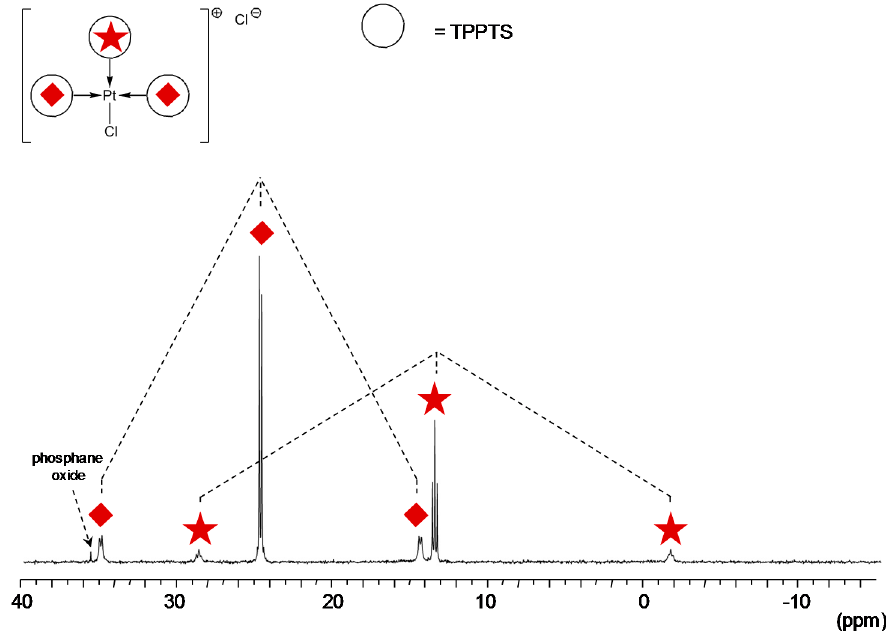
Figure 1. 31 P{ 1 H} NMR spectrum of [Pt(TPPTS) 3 Cl]Cl, [Pt] = 10 mM, 25 ◦ C in D 2 O.